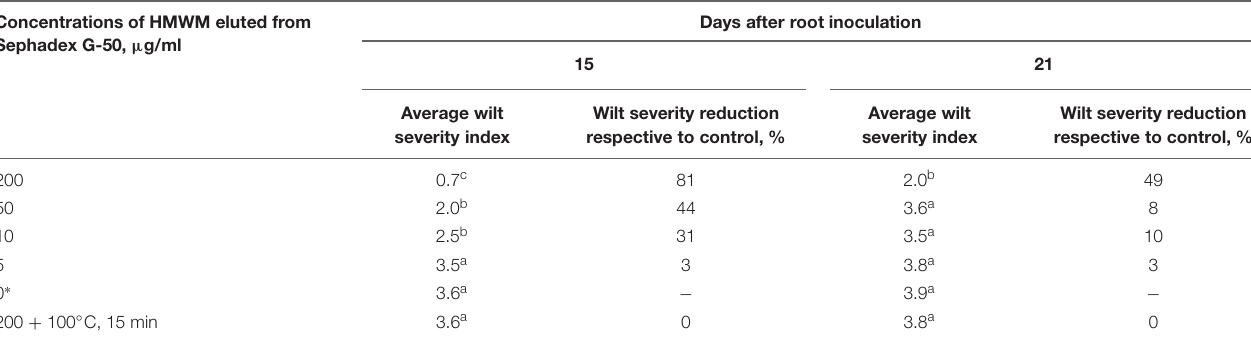
TABLE 1 | Reduction of wilt severity on tomato seedling pre-treated with high-molecular weight metabolites (HMWM) isolated from biocontrol Fusarium oxysporum strain CS-20. Concentrations of HMWM eluted from Sephadex G-50, µ